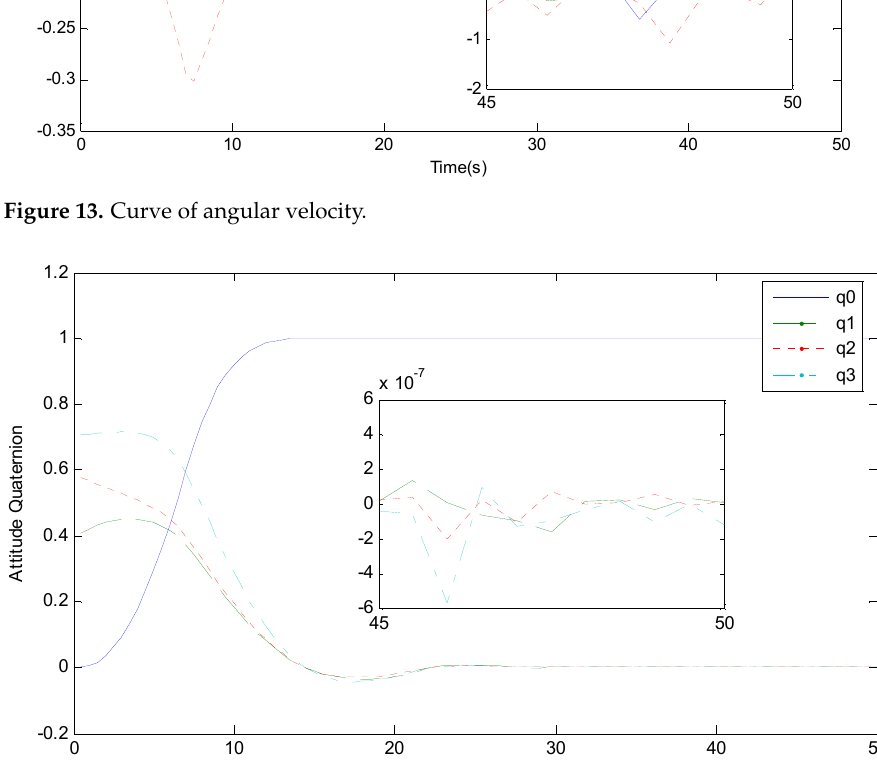
Figure 14. Curve of attitude quaternion.